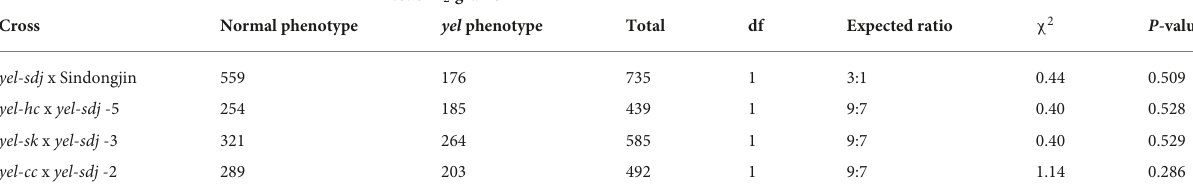
TABLE 2 Genetic analysis of the yel - sdj